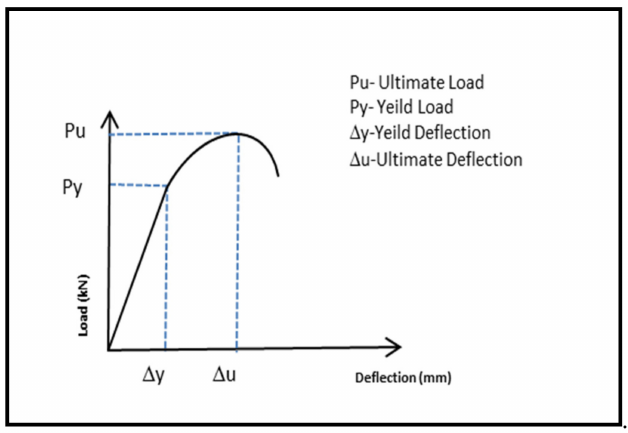
Figure 14. Displacement Ductility (Thamrin et al.